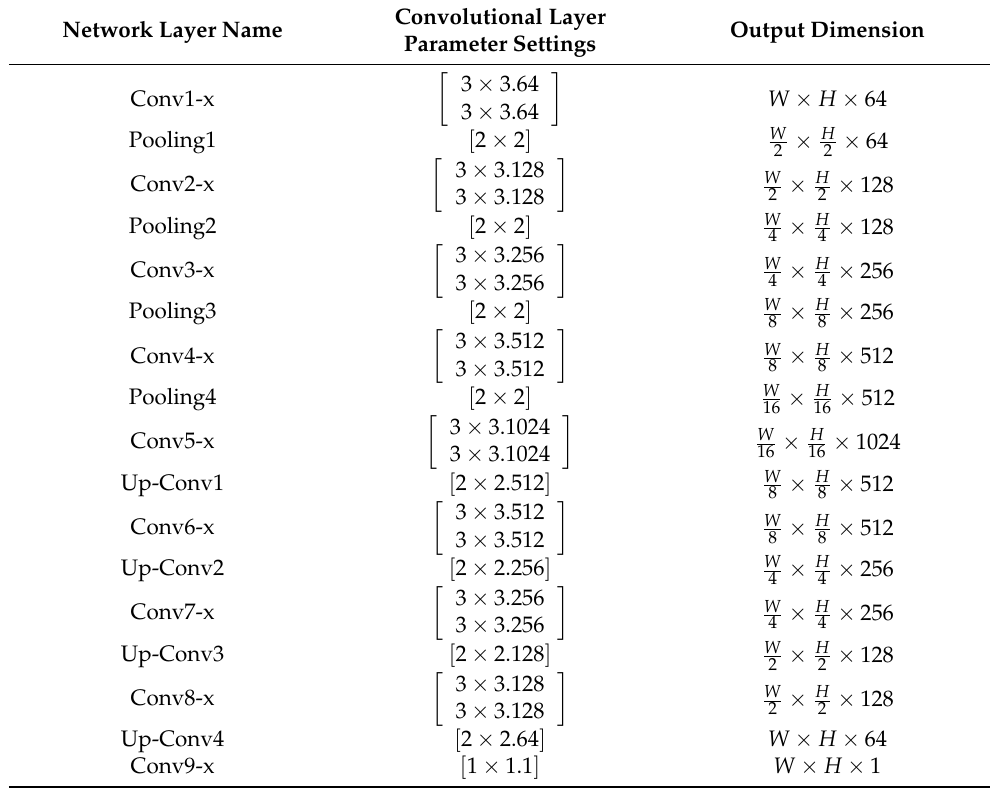
Table 1. The parameter setting of U-Net network